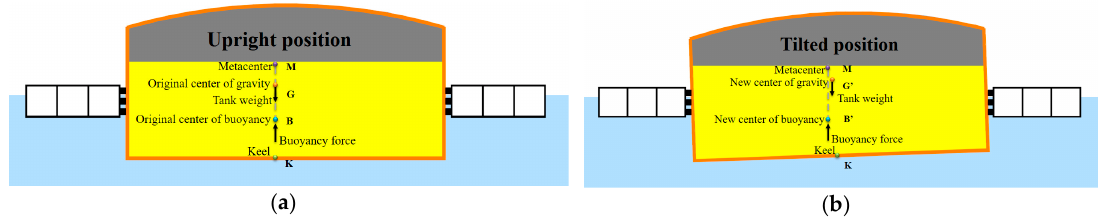
Figure 11. Floating tank at ( a ) upright and ( b ) tilted positions.